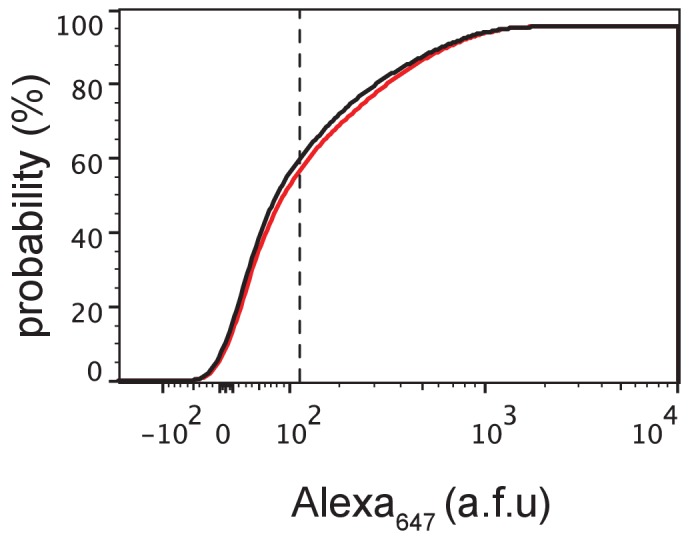
. iN-CHIP does not modulate surface expression of untagged BBS-Q1.Cumulative distribution histograms of Alexa647 fluorescence in cells expressing BBS-Q1 + FKBP-nano + FRB-CHIP after addition of DMSO (black) or rapamycin (red) for 20 hr.